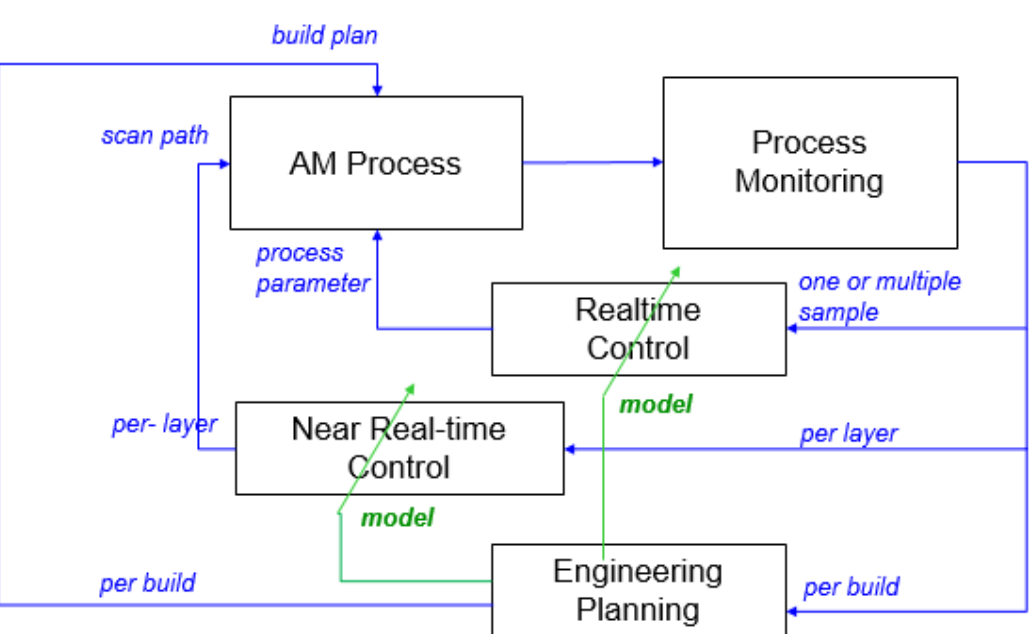
Figure 1. Multi-loop control architecture.